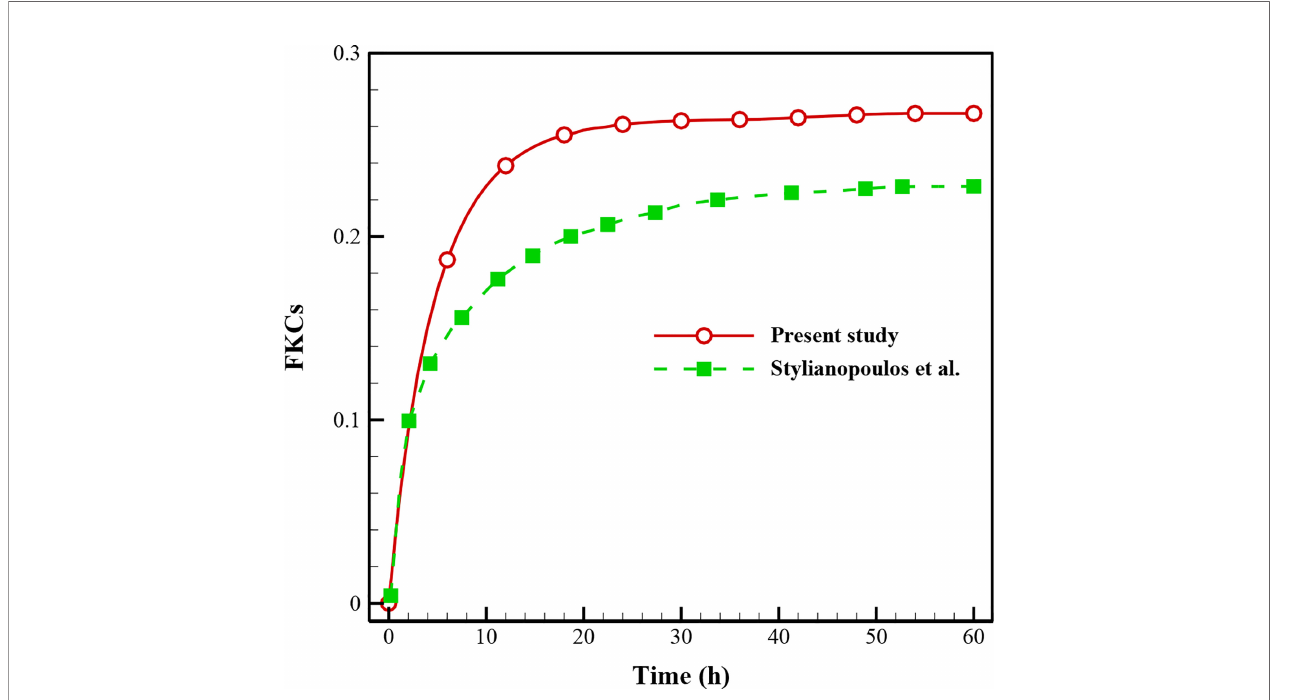
FIGURE 4 | Comparison of the results with previously published study (28) using FKCs over